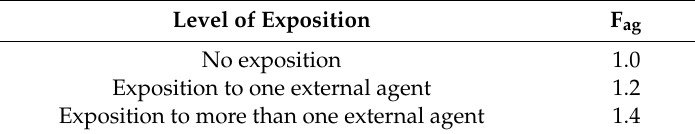
Table 5. Values for exposition to aggressive agents’ factors (F ag ).